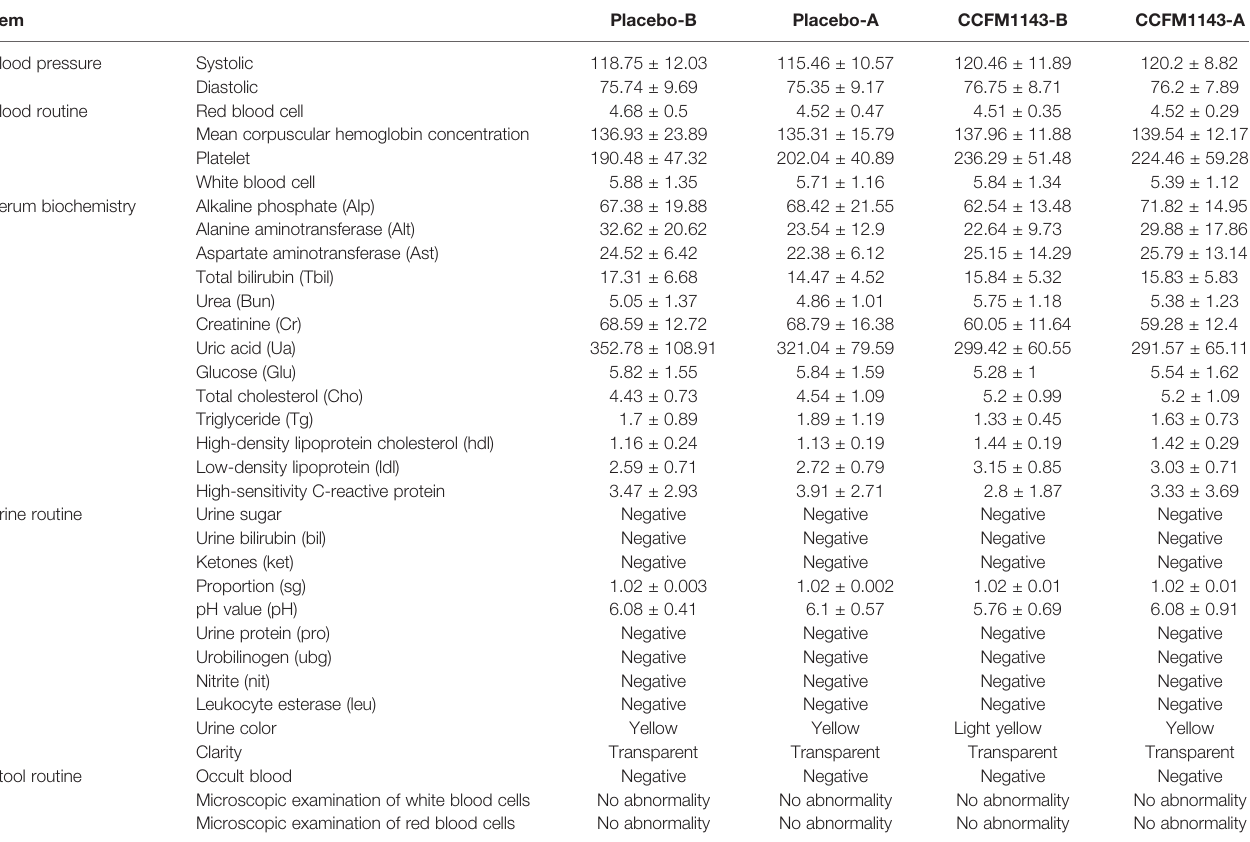
TABLE 3 | Information on the routine physical examination for patients with diarrhea.